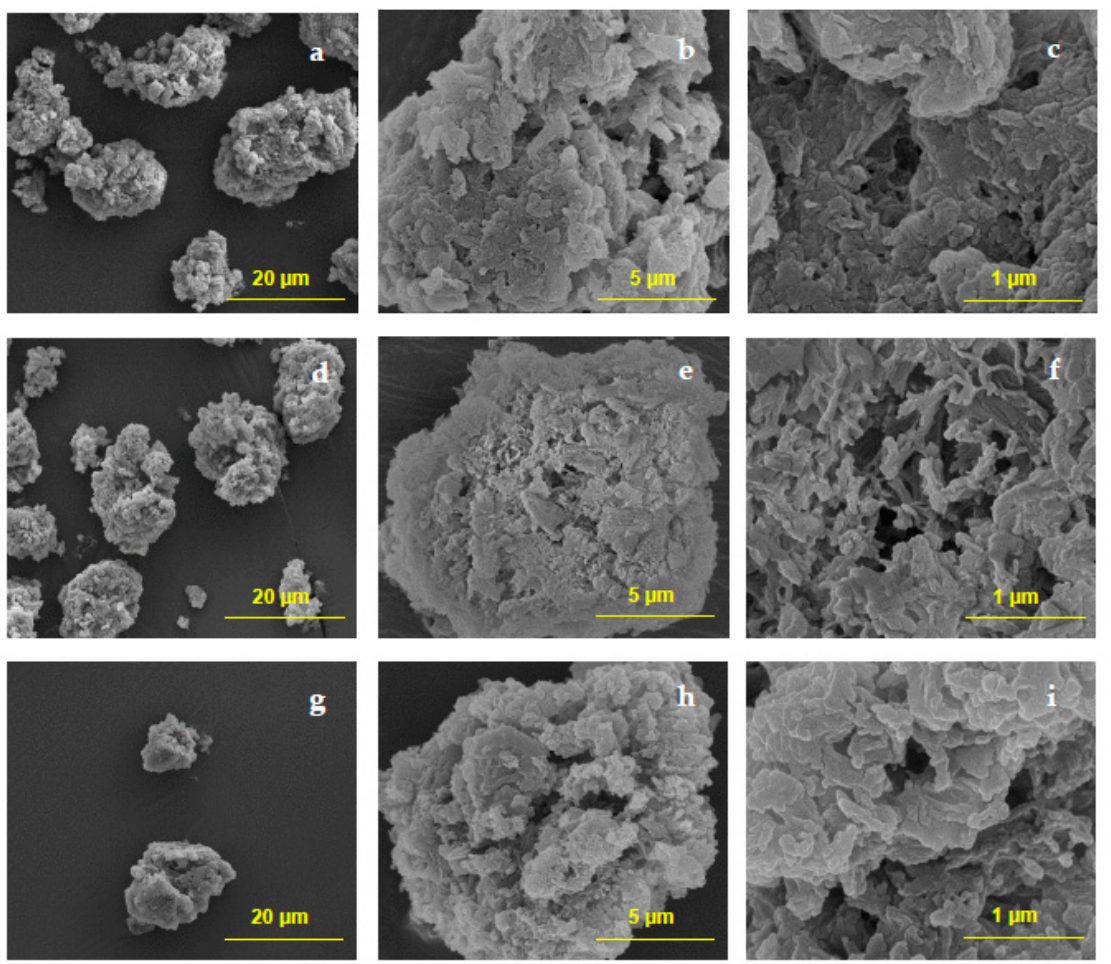
Figure 3. SEM images of laccase-entrapped PA4@eL: ( a – c ) PA4@eL; ( d – f ) PA4-Fe@eL; ( g – i ) PA4-Fe 3 O 4